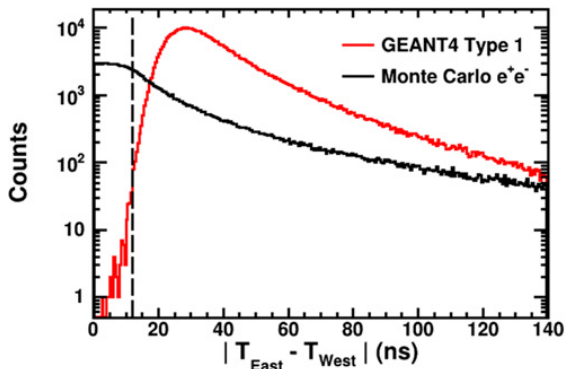
Figure 5. A simulated timing spectrum of a Type 1 decay event (red) vs. a e + e − dark matter decay event (black), assuming a 1% branching ratio for the dark matter decay. The timing spectrum is generated by sampling a simple three-body phase space for the χ, e + , e − and assuming the maximum available summed kinetic energy, 644keV, for the e + e − pair. The dotted line represents the chosen timing window for this analysis. Bin width of 50ps.